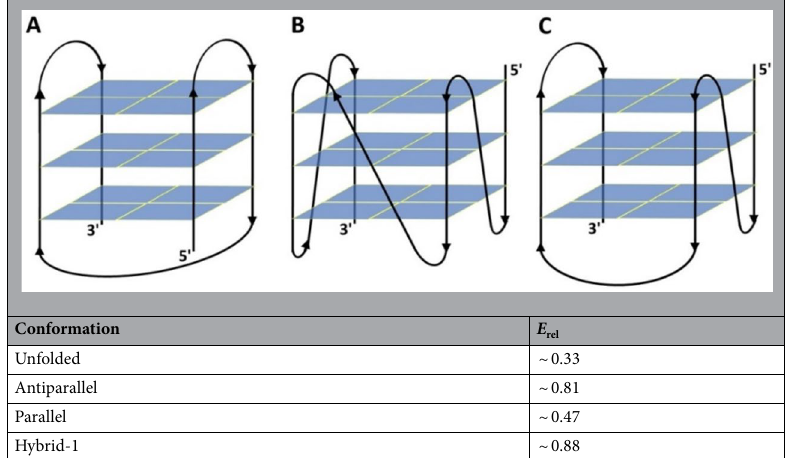
Table 2. Relative FRET efficiency ( E rel ) for the various conformations of 22AG as inferred from the comparison of the FRET and CD data at p = 1 bar and T = 25 °C. The scheme at the top depicts the quadruplex structures adopted by the 22AG sequence: (A) the antiparallel, (B) the parallel, and (C) the hybrid-1 conformation. In the labeled sequences, the donor (FAM) is located at position 5 ′ , and the acceptor (TAMRA) in position 3 ʹ